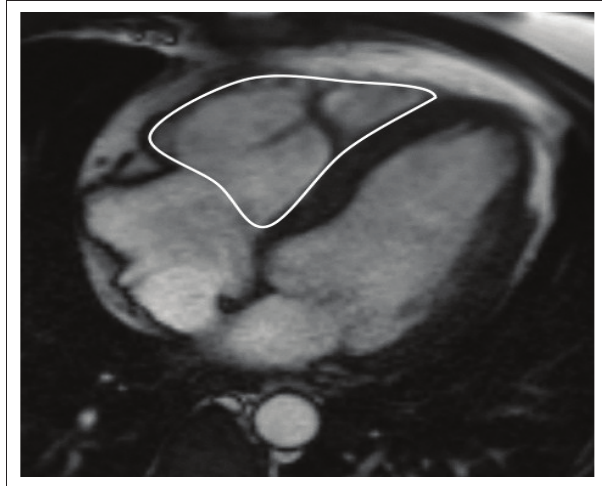
FIGURE 8: Transaxial cine SSFP image of the heart. The levels of the tricuspid and pulmonary valves are easily visualised on the transaxial images for the contouring of the RV volumes and function (white